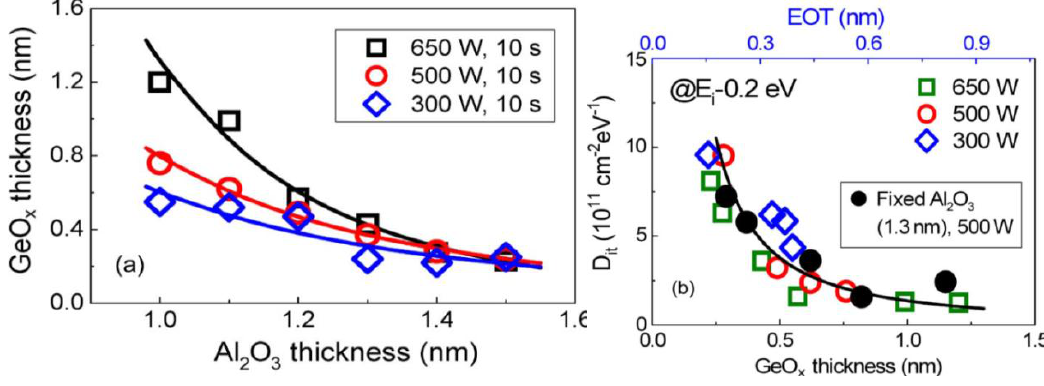
IL s with different Al x